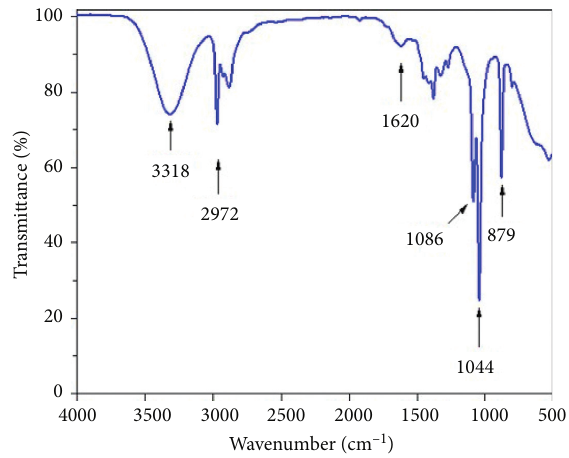
Figure 8: FT-IR spectra of polysaccharides. Table 5: IC 50 values of the